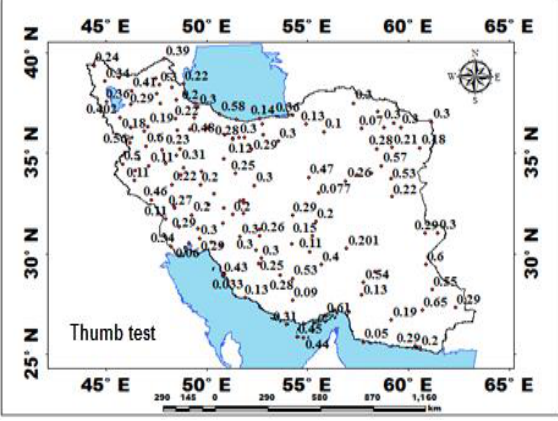
Figure 9. Values of the Thumb test.